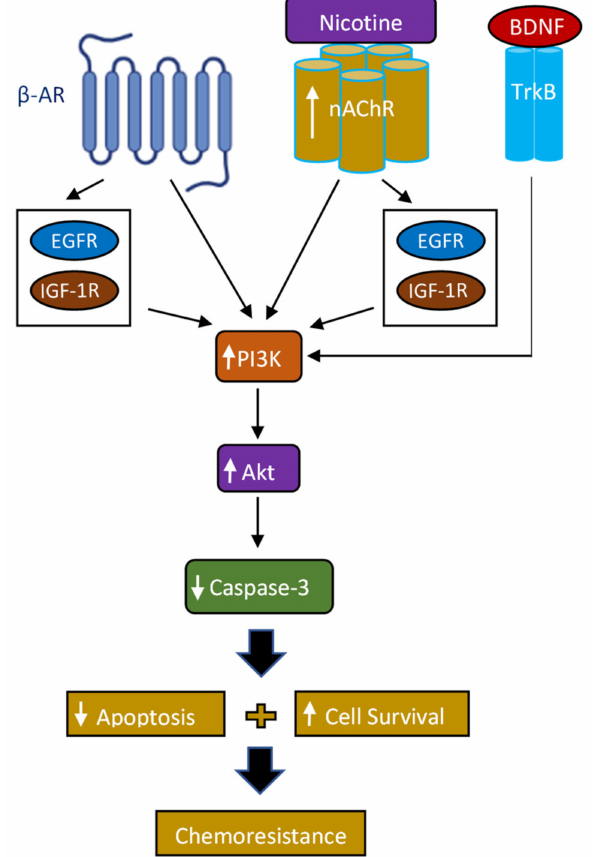
Figure 7. Representation of the main hypothesis and findings of this